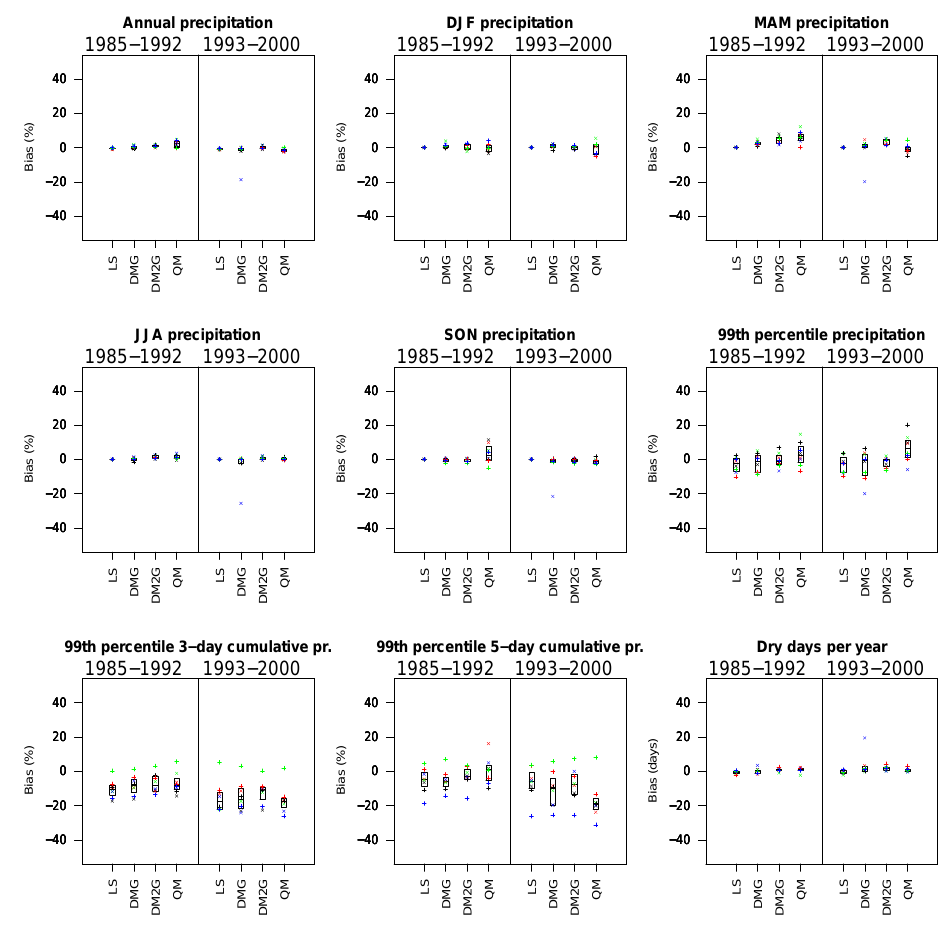
Figure 7. Differences between bias-corrected RCM and raw RCM simulations in change signals in precipitation characteristics between the periods 1985–1992 and 1993–2000. The left and right panels indicate the validation periods in each